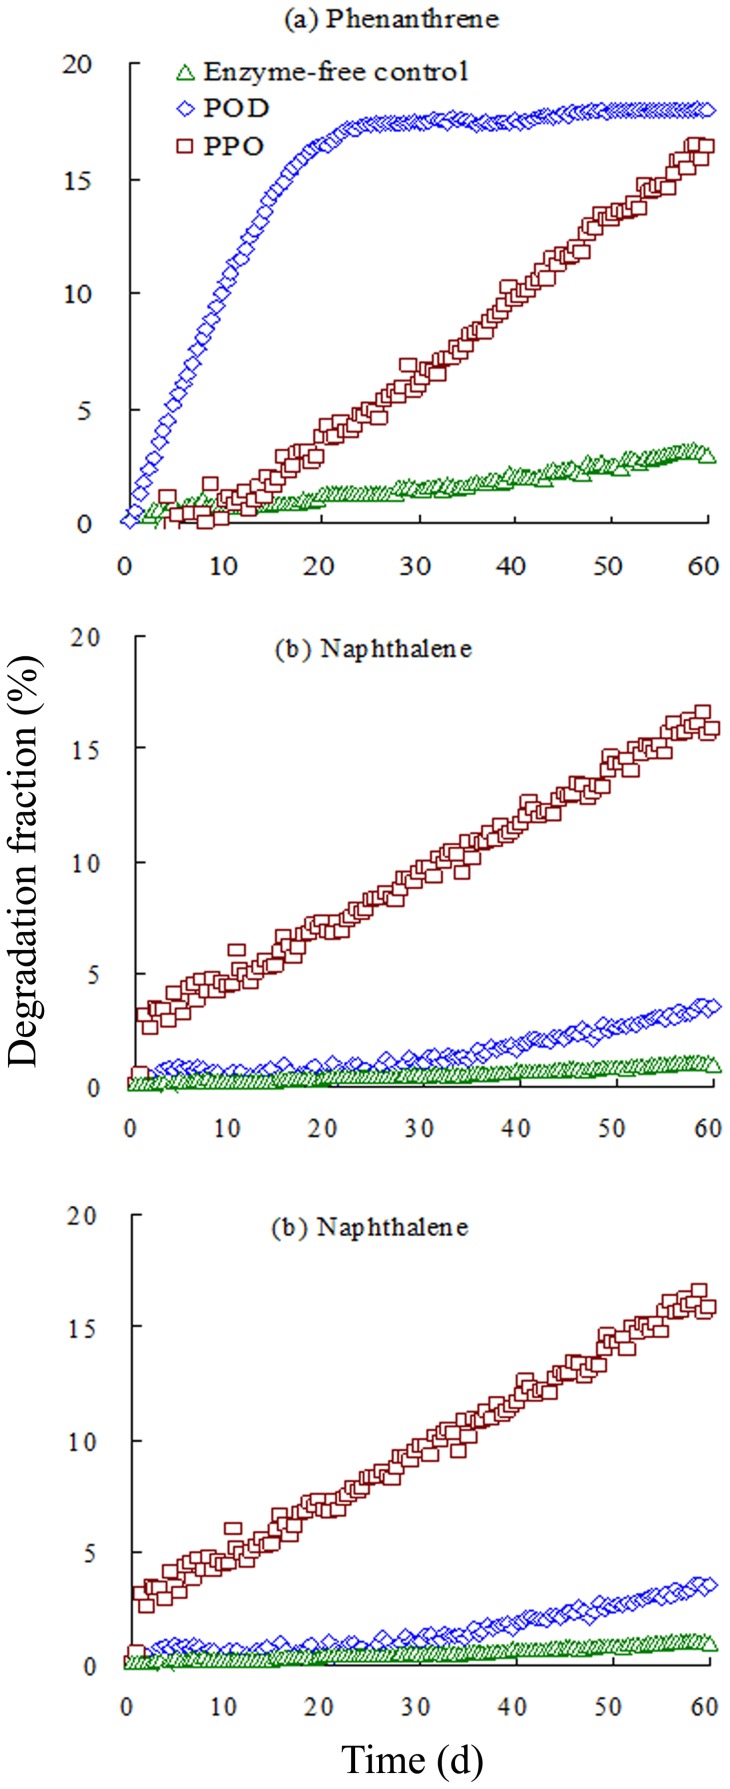
In vitro degradation fraction (%) of added (a) phenanthrene, (b) naphthalene, and (c) anthracene by POD and PPO over timeThe degradation fraction (DPAH, %) of PAHs was estimated as: DPAH  =  (CPAH-o – CPAH-i)/CPAH-o×100%, where CPAH-i and CPAH-o represent the PAH concentrations in solution at time i and time 0, respectively.